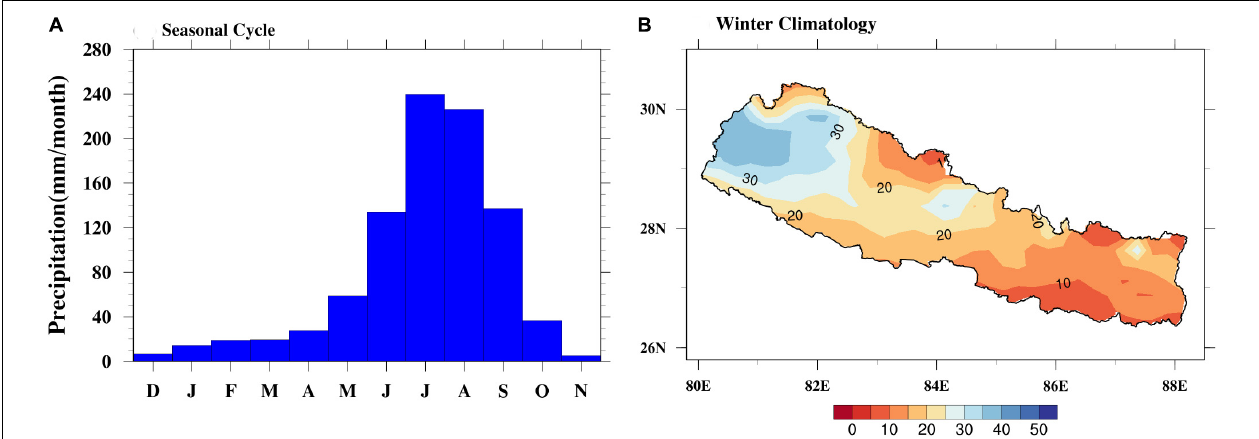
FIGURE 3 | (A) Seasonal cycle and (B) Climatology of winter precipitation (mm/month) over Nepal using APHRODITE data from 1987 to 2015.